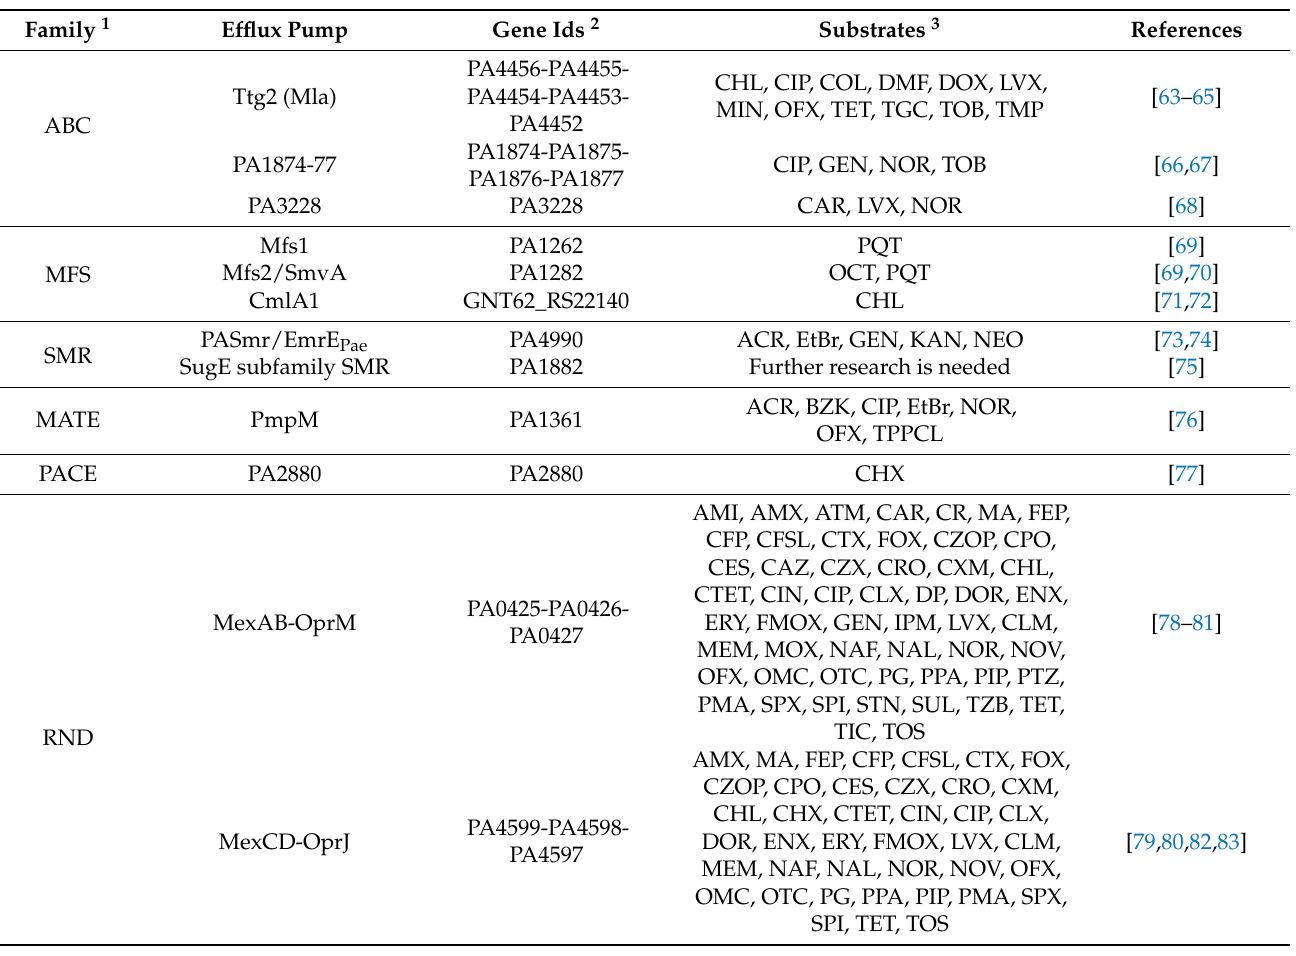
Table 1. Major families of bacterial efflux pumps in P. aeruginosa